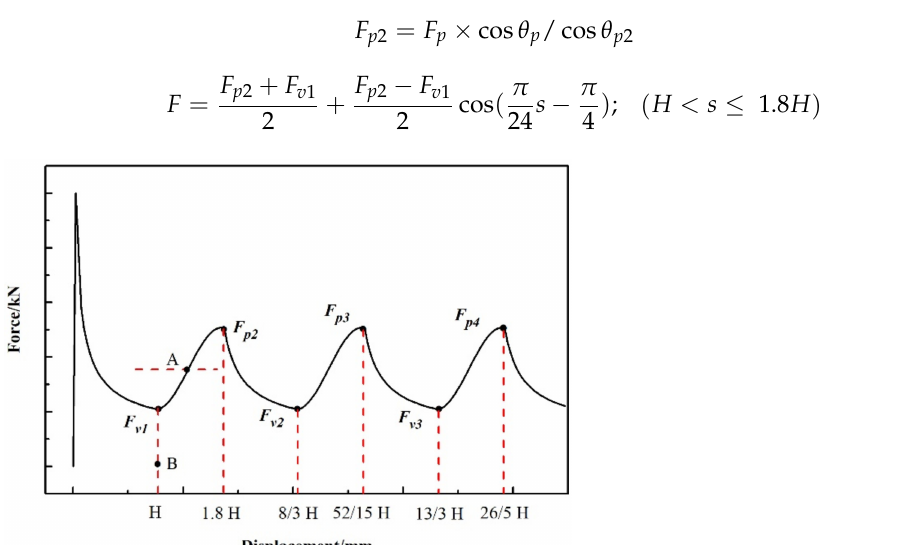
Figure 13. Schematic diagram of calculation in compaction and folding stages.